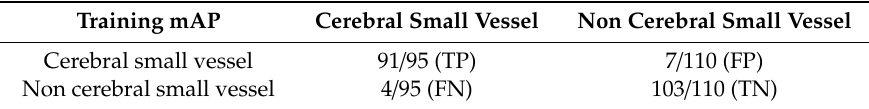
Table 5. Training mAP of YOLO2 model.